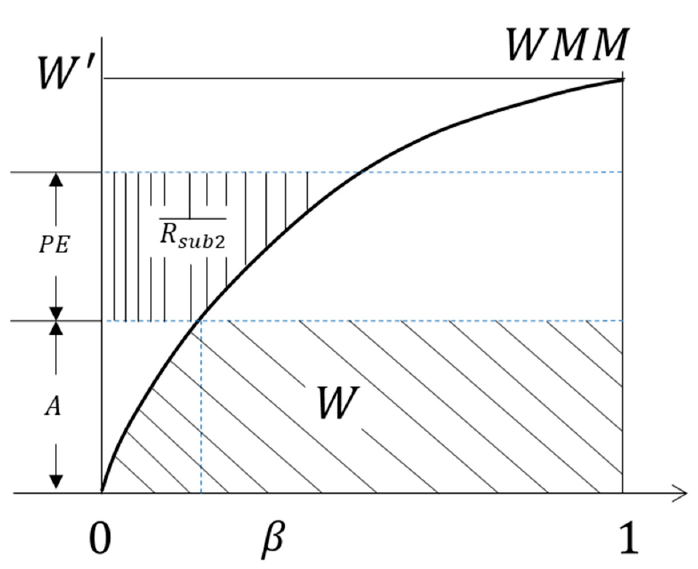
Figure 3. Distribution curve of water storage capacity over the basin. Note: PE = P − E . The denotations of the symbols can be seen in text in Section 2.